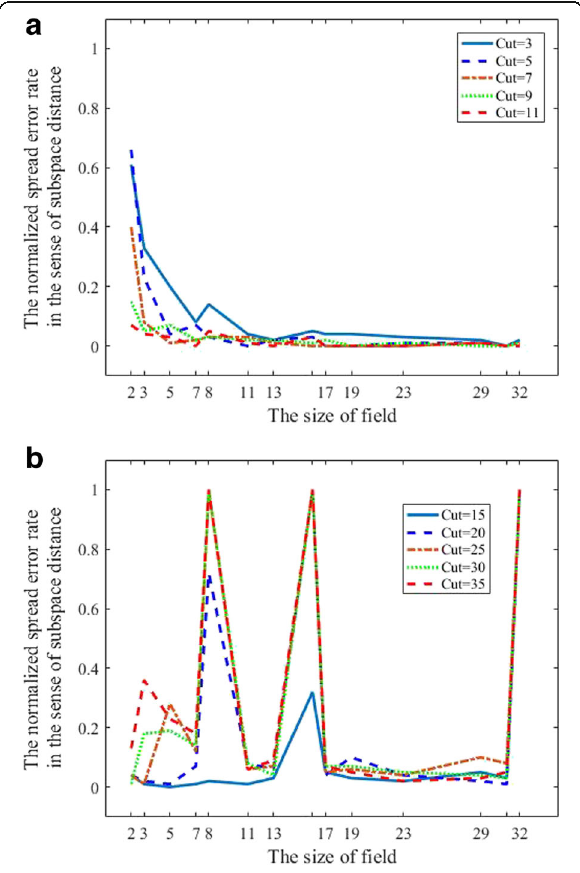
Fig. 2 The spread of errors in the sense of subspace